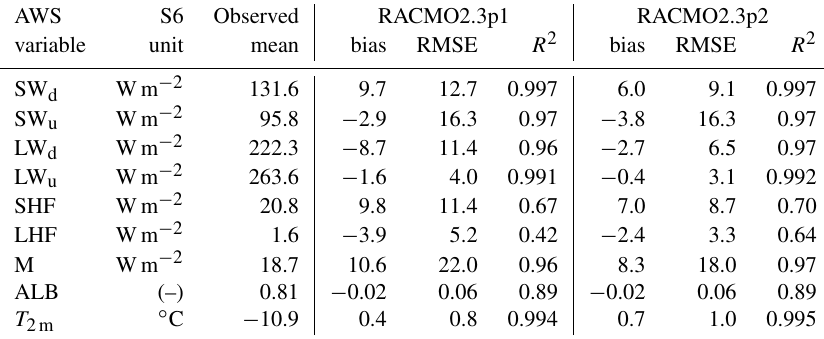
Table 3. Modelled and observed mean SEB components and statistics of the differences (2004–2015) at station S6 in the upper ablation zone (1010ma.s.l.). Statistics include means of measurements collected at S6, model bias (RACMO2.3pX – observations), RMSE of the bias as well as the determination coefficient of monthly mean data. All fluxes are set to